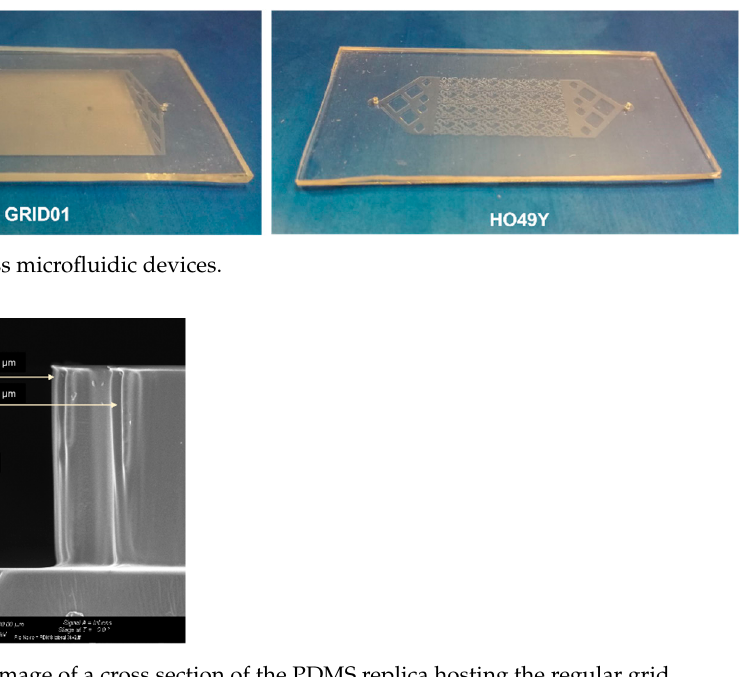
Figure 7. Scheme of the soft lithography process used for the fabrication of the microfluidic devices. ( a ) Fabrication of the master mold via lithography ( b ) PDMS casting and molding, followed by Oxygen plasma bonding.